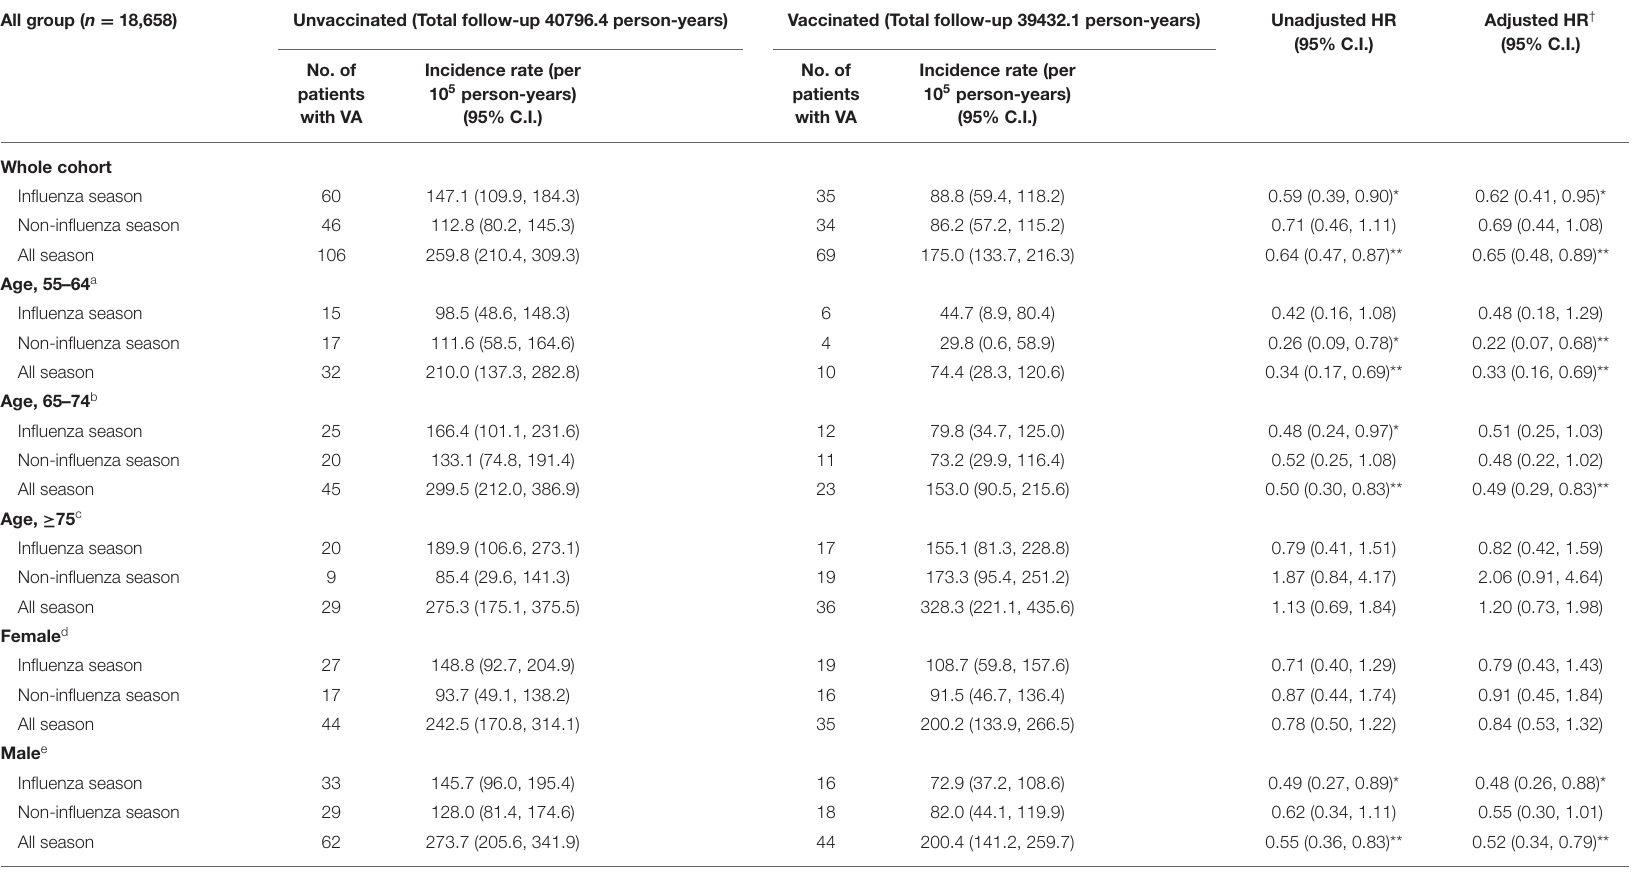
TABLE 2 | Risk of ventricular arrhythmia among unvaccinated and vaccinated in study cohort. All group ( n = 18,658) Unvaccinated (Total follow-up 40796.4 person-years) Vaccinated (Total follow-up 39432.1 person-years) Unadjusted HR